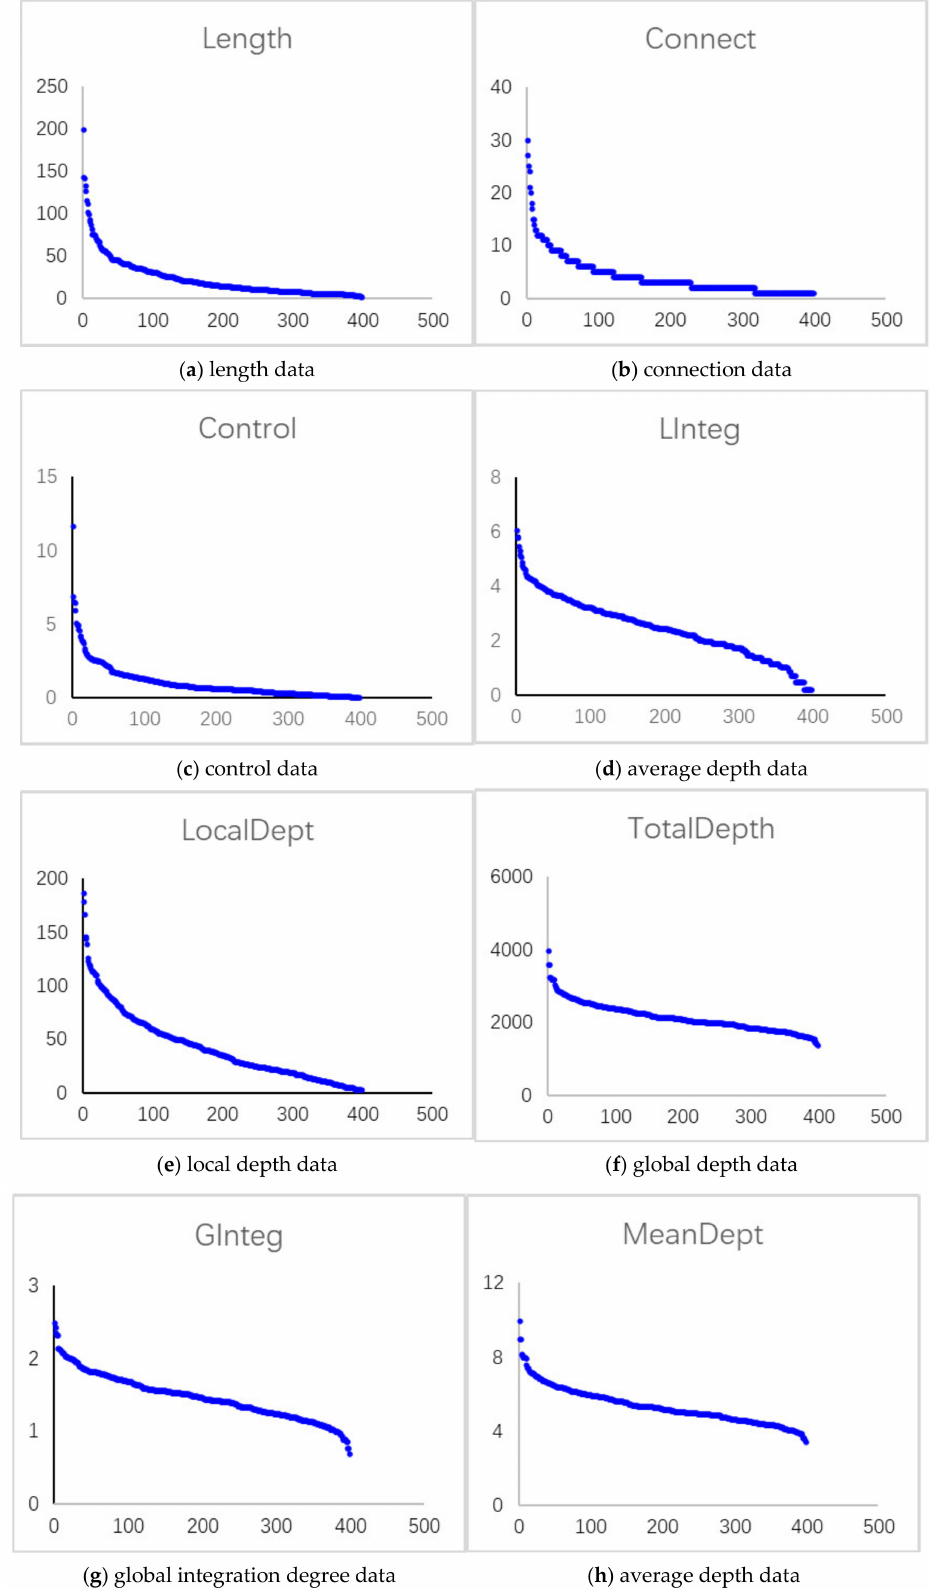
Figure 8. Power law analysis of metric and length of space syntax in (Figure 5 fracture network diagrams ( c )) (the horizontal axis data represent the fracture ID, and the vertical axis data are the dimensionless data of these 8